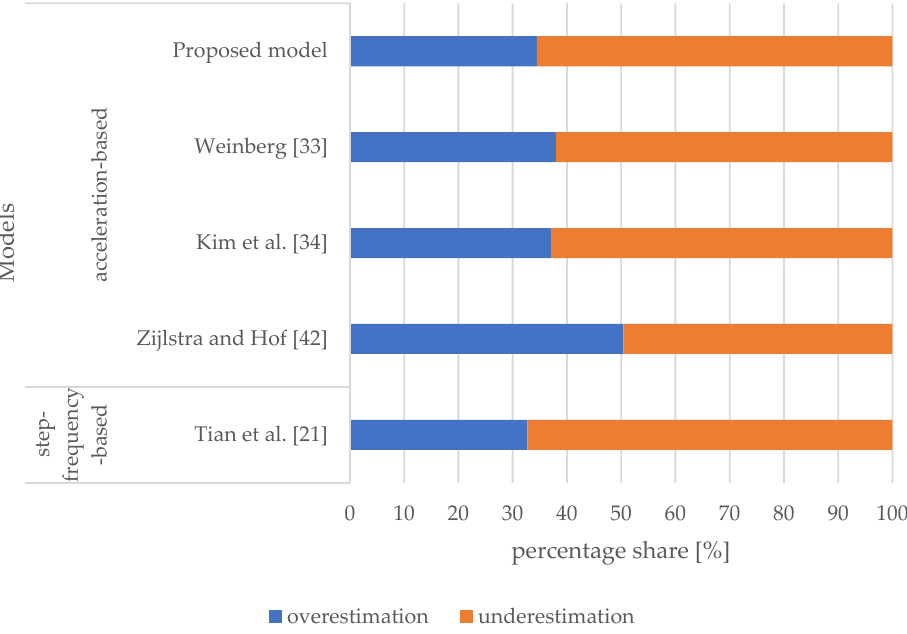
Figure 4. Percentage shares of overestimated and underestimated stride lengths for the selected models.